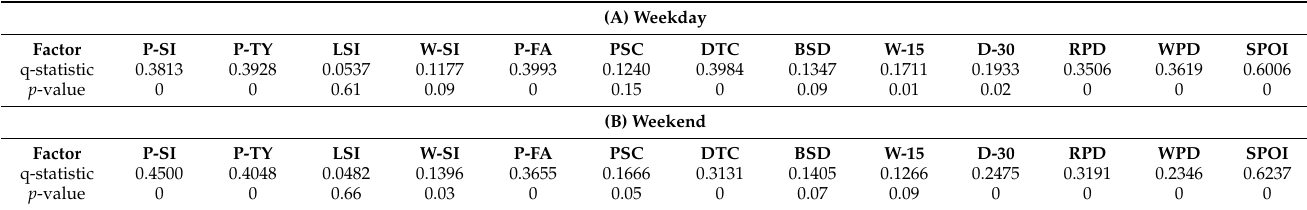
Table 2. Results from factor detector analysis between urban park use and the affecting factors (A) Weekday; (B) Weekend.